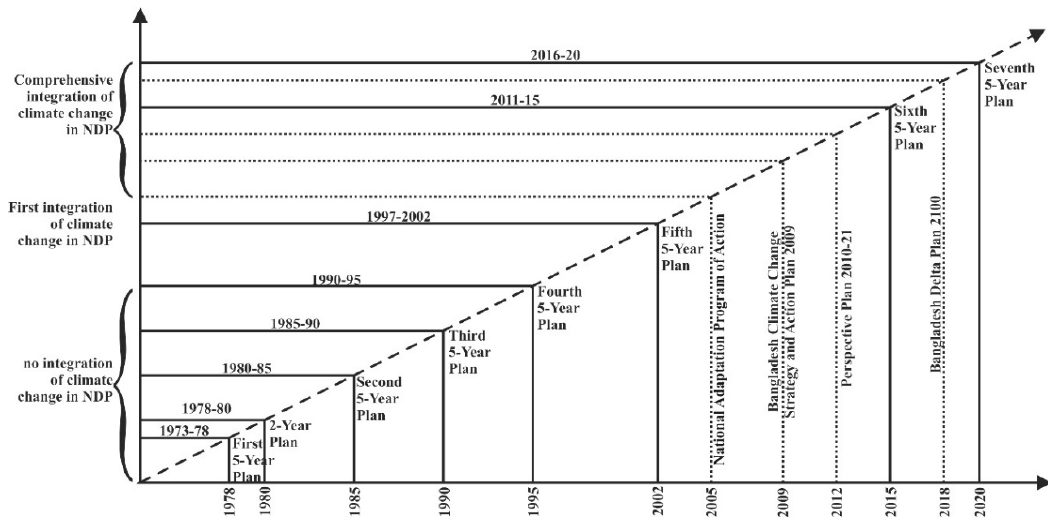
Figure 3. NDPs and sectoral plans implementation period (Authors’ elaboration after Diko [20]).